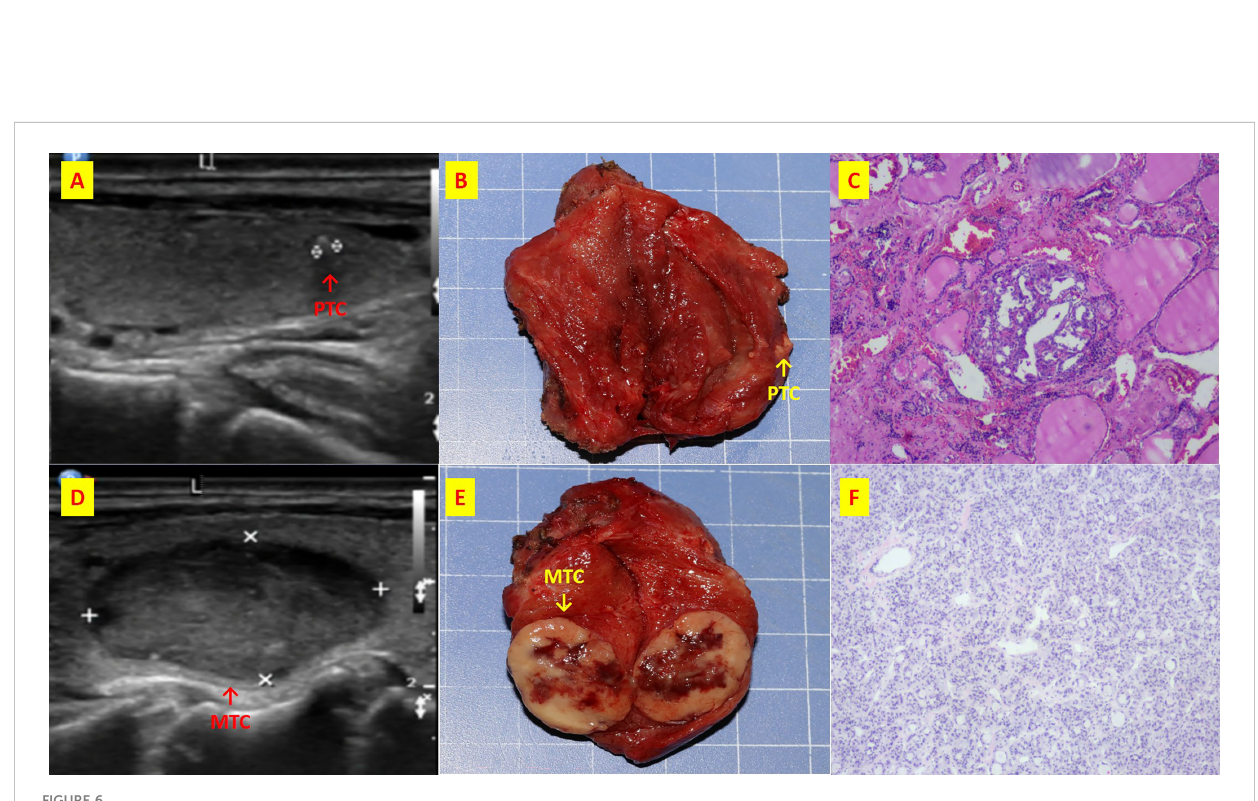
FIGURE 6 The patient n.26 that MTC and PTC are located in the different thyroid lobe respectively. (A) ultrasound of longitudinal of right PTC; (B) Intraoperative resection of PTC tumor pro fi le; (C) Histological sections of HE x40 of PTC; (D) ultrasound of longitudinal of left MTC; (E) Intraoperative resection of MTC tumor pro fi le; (F) Histological sections of HE x40 of